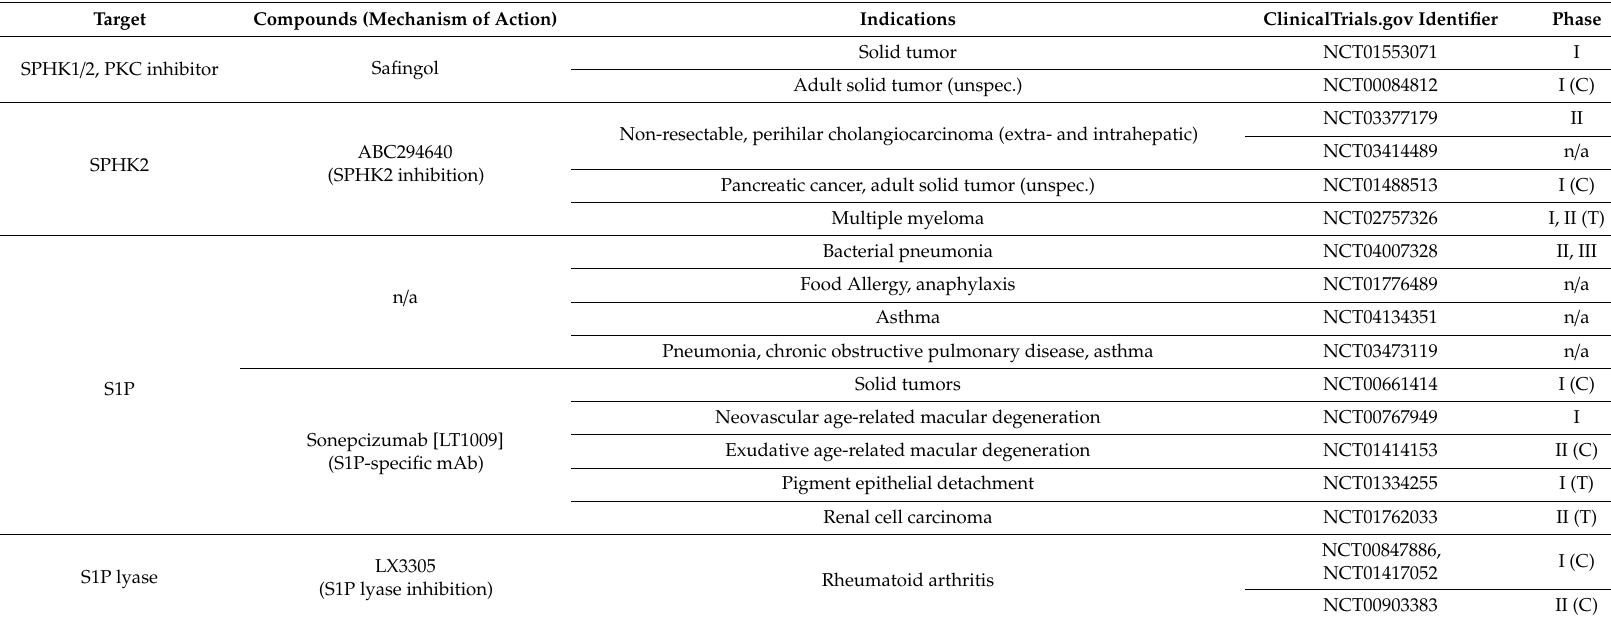
Table 1. Trials of drugs interfering with the sphingosine 1-phosphate metabolism in clinical conditions. (C), completed; (T), terminated; (S), suspended (one study currently on halt due to COVID-19-related recruitment stop); SPHK1 / 2, sphingosine kinase 1 / 2; PKC, protein kinase C; S1P, sphingosine 1-phosphate; S1P n , S1P receptor